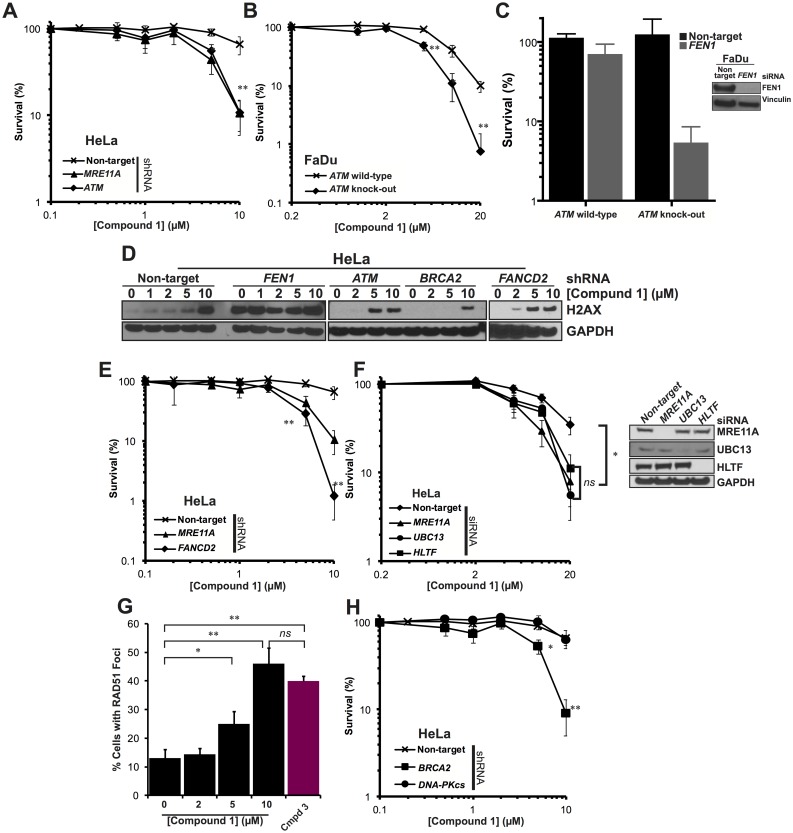
Cells disrupted for pathways required to maintain replication fork stability are sensitive to inhibition of FEN1.A. Clonogenic survival of cells stably expressing shRNA against MRE11A, ATM or a non-targeting control when treated with 1. B. Clonogenic survival of FaDu cells or FaDu cells with all three ATM alleles knocked-out when treated with 1. C. Clonogenic survival of FaDu cells or FaDu cells with all three ATM alleles knocked-out when treated with siRNA against FEN1. D. DNA damage response induced in cells expressing shRNA against FEN1, ATM BRCA2, FANCD2 and a non-target control. E-F. Clonogenic survival of cells disrupted for FANCD2 by shRNA (E) or genes required for PRR (UBC13, HLTF) by siRNA (F) compared to a non-target control. (G) Accumulation of Rad51 foci in cells treated with 1. Data is collected from at least 500 cells per treatment. H. Clonogenic survival of cells disrupted for genes required for HR (BRCA2, BLM) and NHEJ (DNA-PKcs) by shRNA compared to a non-target control. In each clonogenic assay, data points represent the mean of at least 3 individual repeats and the error bars represent the standard error. Significance was determined by Student t-test. ns = not significant * p < 0.05. ** p < 0.005